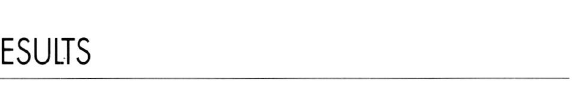
Figs 1-8. — Giemsa-stained blood film of the snake Boa c. constrictor infected with Hepatozoon cf. terzii. Figs 1-6. Ma ture, encapsulated gametocytes in ery throcytes: double infection in Figure 5. Figs 7-8. Heavily stained gametocytes, presumably immature and without a fully developed capsule. Bar = 10 µm for all